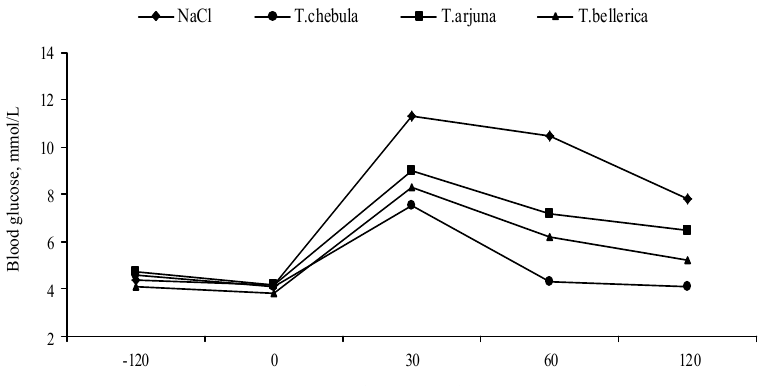
Figure 1. In normal fasted rats blood glucose levels, significantly changed at different time intervals after oral administration of extracts and glucose load ( p